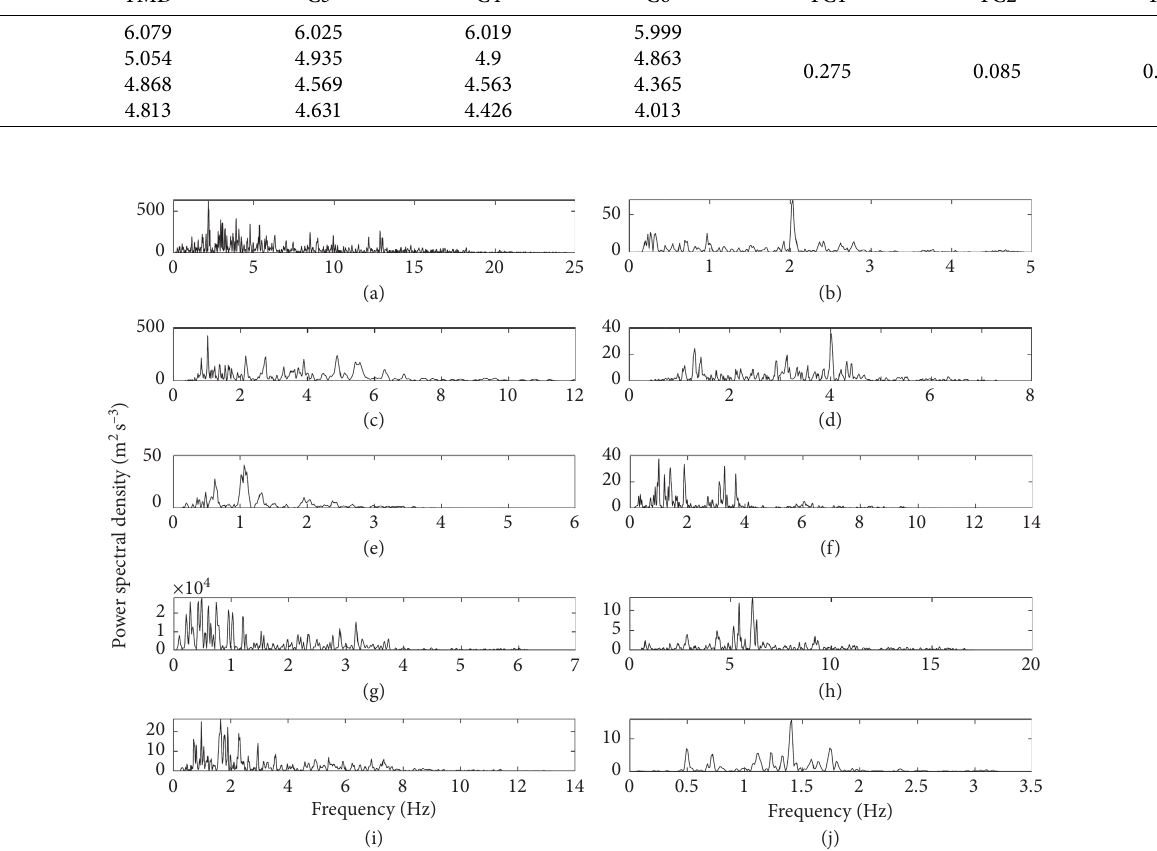
Figure 10: Power spectral density of various seismic wave accelerations. (a) Chichi. (b) Friuli. (c) Hollister. (d) Imperial Valley. (e) Kobe. (f) Kocaeli. (g) Landers. (h) Loma Prieta. (i) Northridge. (j)